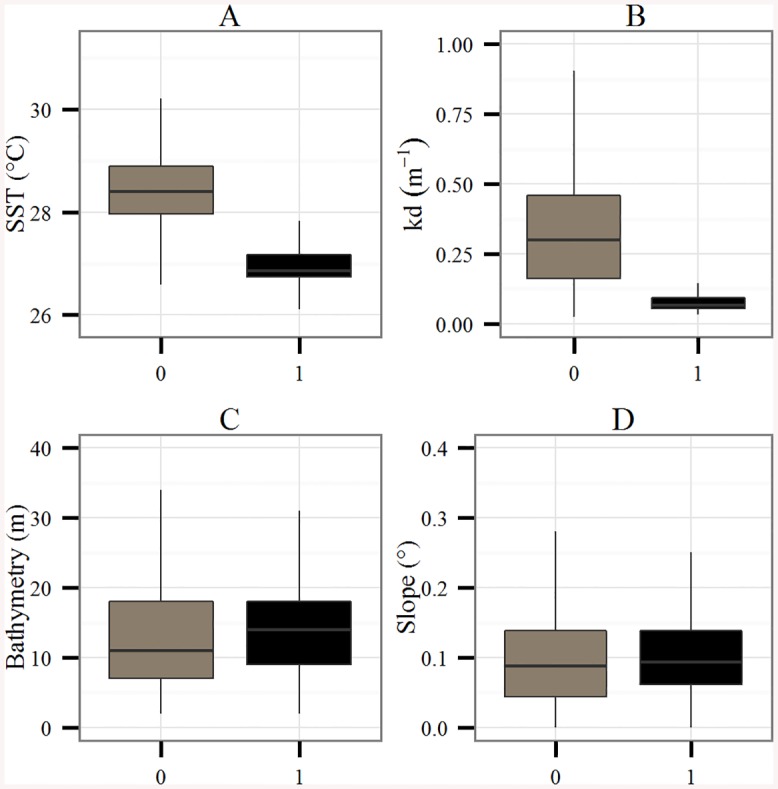
Box plots of (A) the SST (°C), (B) the Kd (m-1), (C) the Bathymetry (m) and (D) the Slope (°) extracted at turtles’ locations for the two behavioral modes, i.e. transiting (grey) and foraging (black).